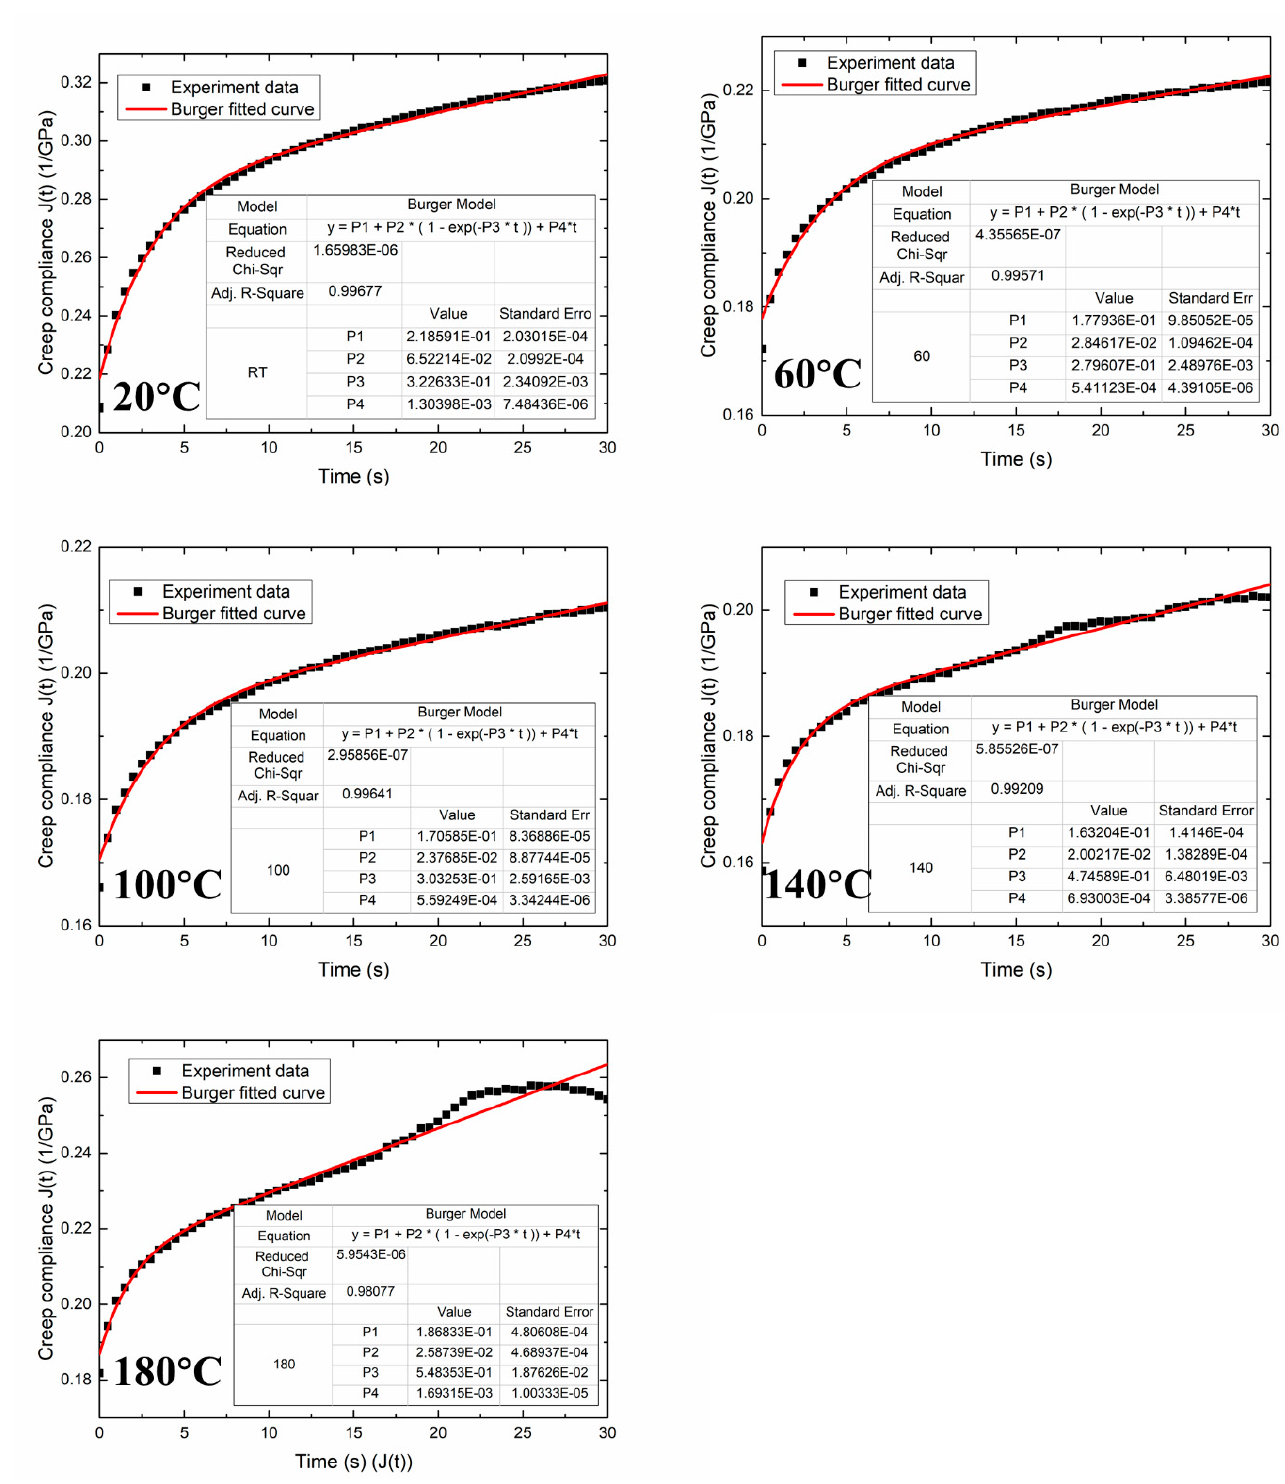
Figure 8. The test data and simulated curves of untreated wood cell wall.